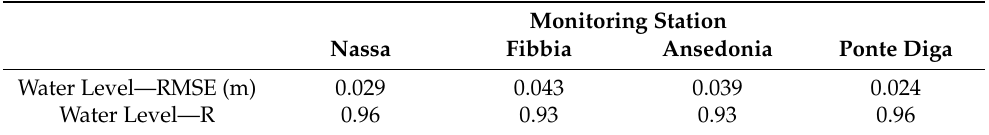
Table 1. Validation of the numerical model for water levels: Root Mean Square Error (RMSE) and correlation coefficient (R) with filed data measured at the different monitoring stations for year 2020. Indexes are relative to the time windows in which the pumping system was turned